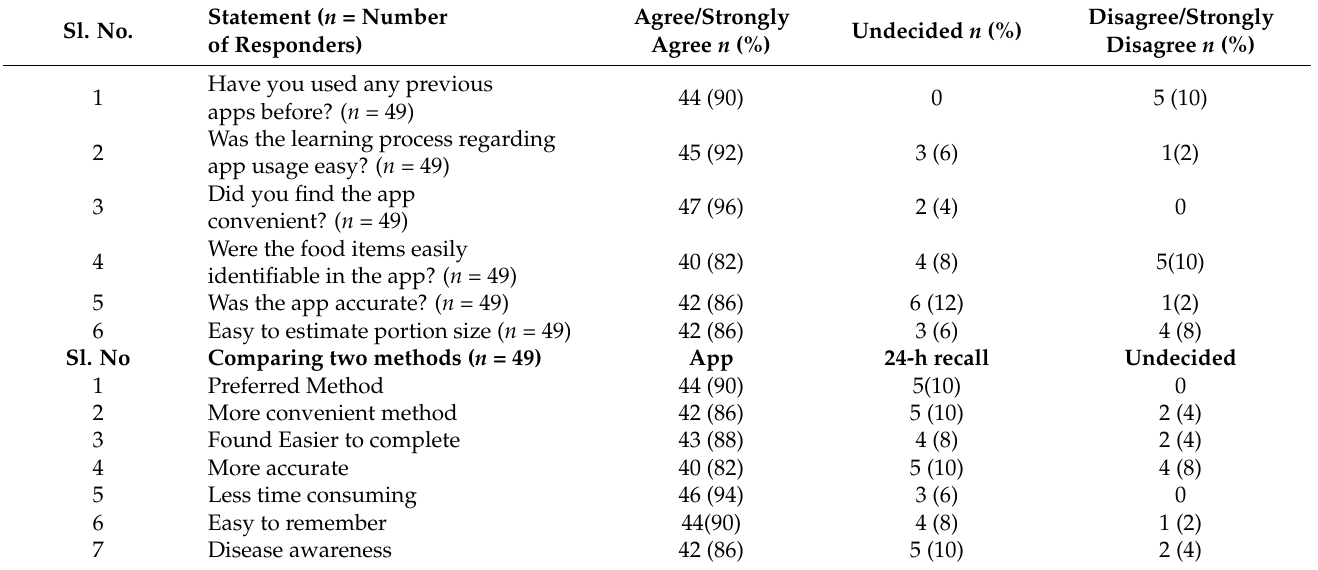
Table 3. Acceptability of the IBD NutriCare